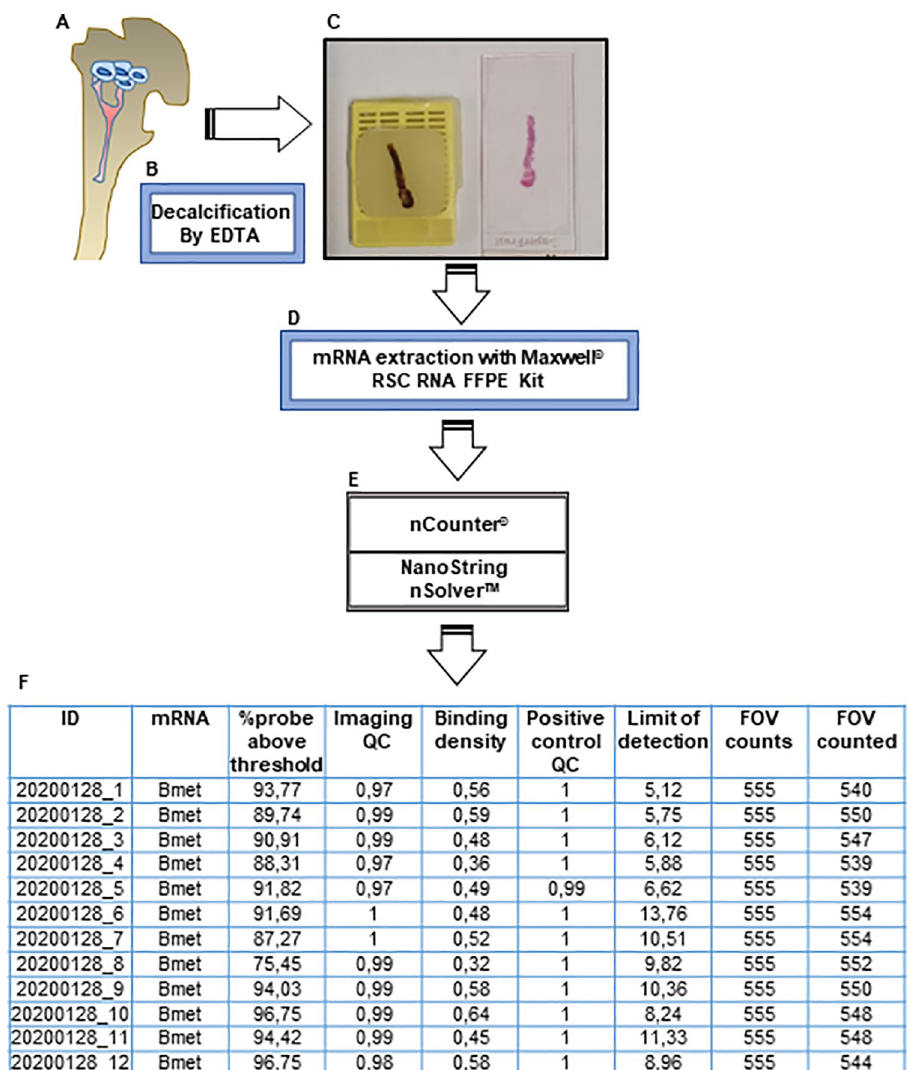
Fig 1. Schematic overview of the workflow. (A) Collecting tissue from PCaBmet patients (B) Decalcification procedure using EDTA (C) Representative picture of DFFPE from PCaBmet tissue (D) mRNA extraction using bead- based Maxwell 1 RSC RNA FFPE Kit (E) Digital QC by nCounter 1 reader and nSolver ™ analysis software provided by NanoString TM (F) Data output from digital QC nSolver ™ analysis software.